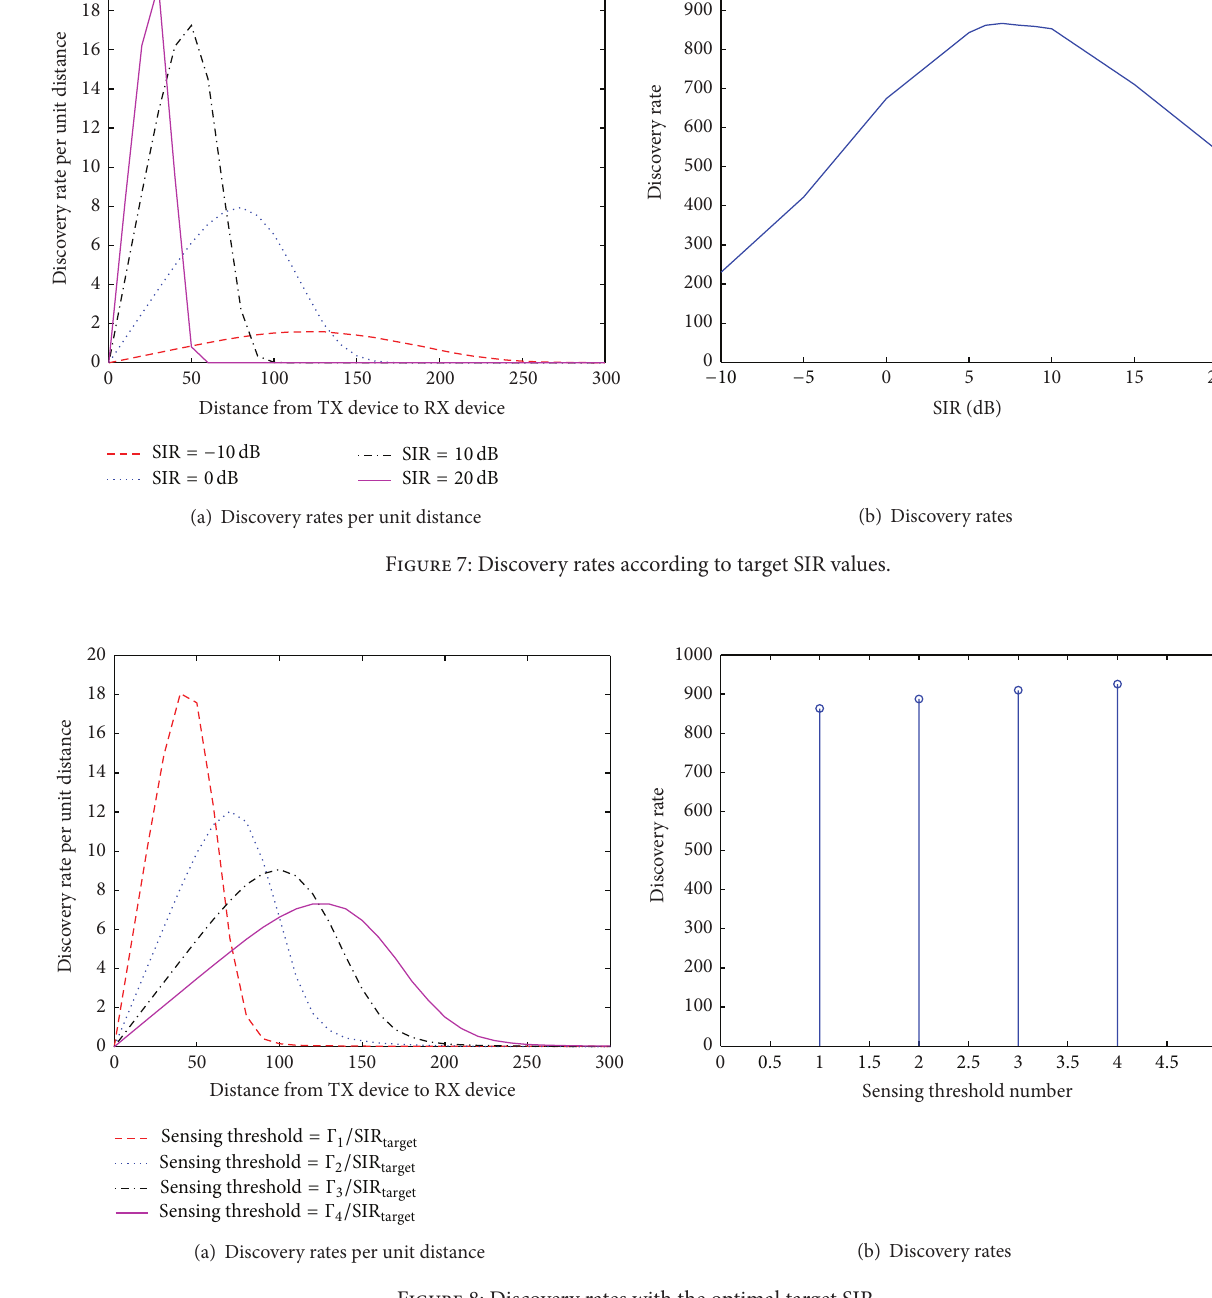
Figure 8: Discovery rates with the optimal target